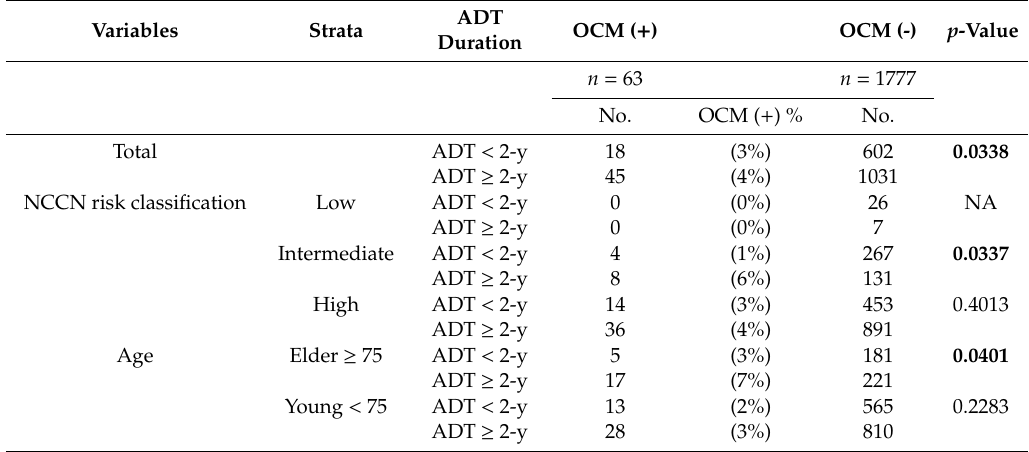
Table 4. Characteristics and treatment factors for OCM according to ADT duration.